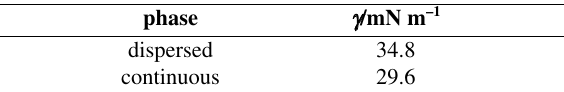
Table 2: Surface tensions of the dispersed and continuous phases at the temperature, ϑ = 30 °C. Concentration dependence was not per- ceived.